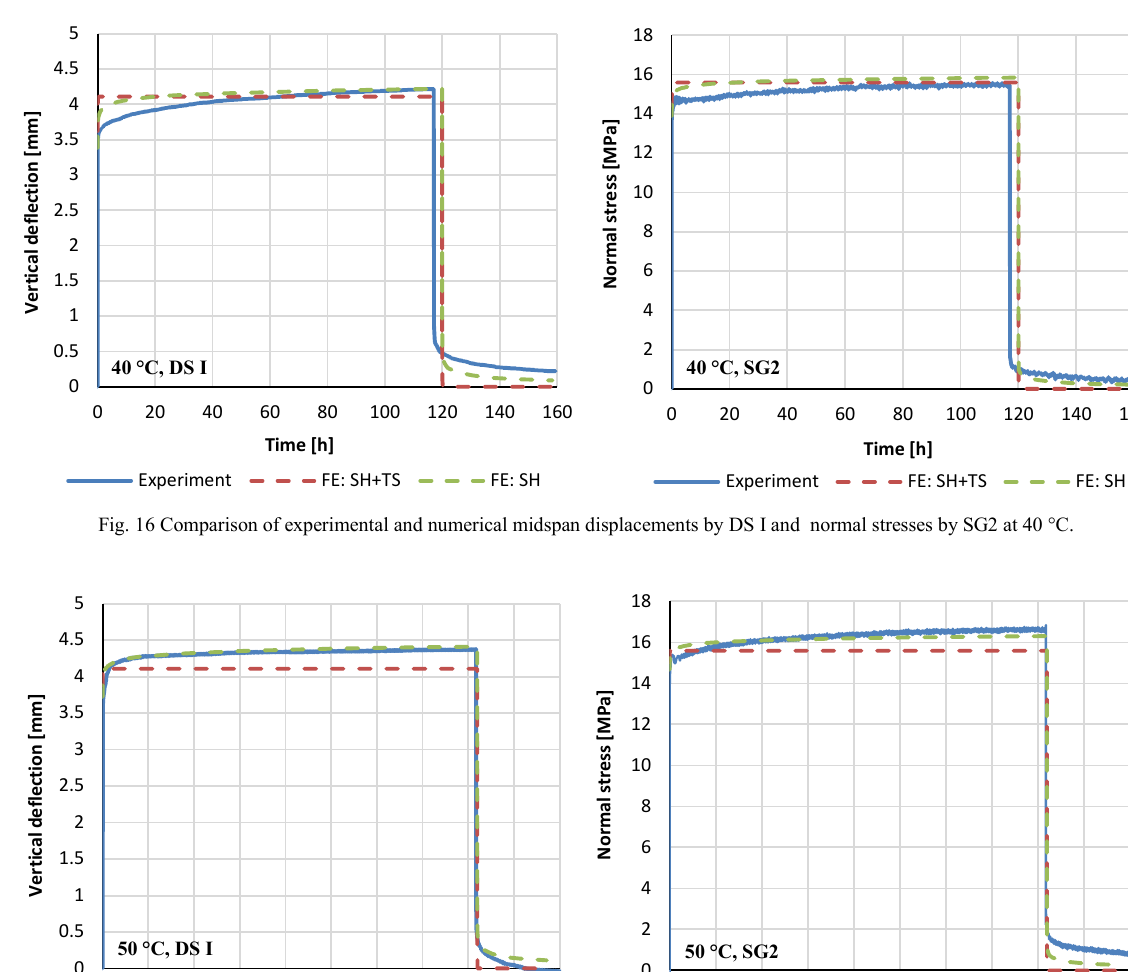
Fig. 15 Comparison of experimental and numerical midspan displacements by DS I and normal stresses by SG2 at 30 °C.